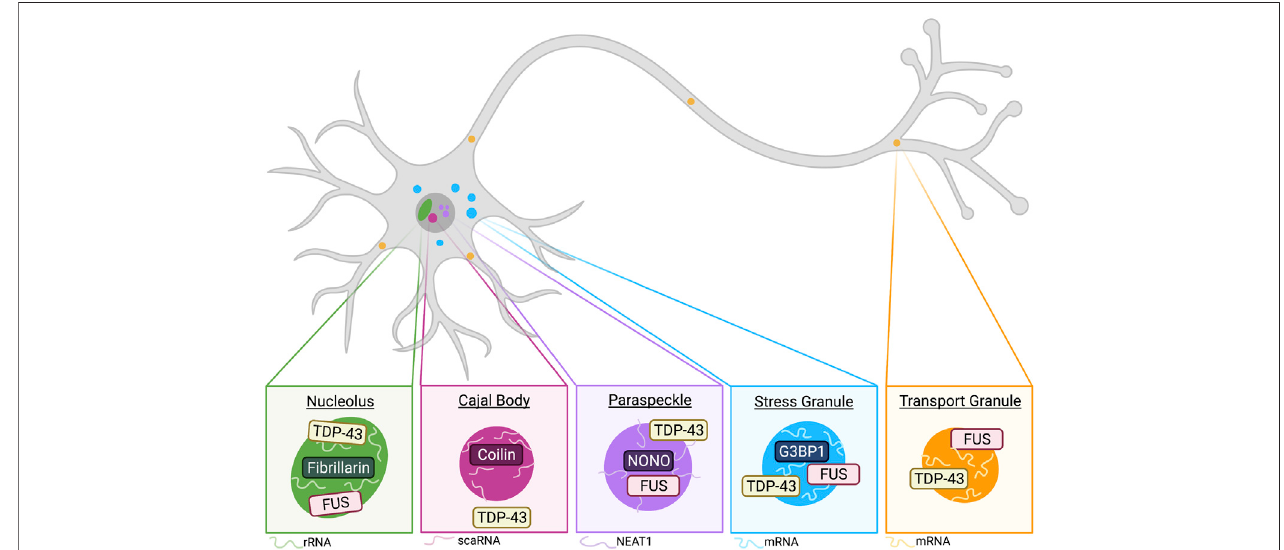
FIGURE 2 | Phase-separated membraneless organelles have distinct components and functions. Schematic of membraneless organelles implicated in TDP-43 and/orFUSbiology.Neuronscontainnucleoli,whicharecondensedregionsassociatedwithribosomalRNAsynthesis.TDP-43andFUShavebeenobservedtolocalize tothenucleolus,whichiscommonlymarkedby fi brillarinandrRNA(see Nucleoli ).Cajalbodies(CBs)arecloselyassociatedwithnucleoliandcommonlyfoundinneurons. Major CB markers include coilin and the presence of small Cajal body-speci fi c RNA (scaRNA). While not demonstrated to colocalize, TDP-43 is implicated in CB formation and regulation (see Cajal Bodies ). Another nuclear membraneless organelle relevant to TDP-43 and FUS biology includes paraspeckles (see Paraspeckles ). The long non-coding RNA (lncRNA) NEAT1 is an integral RNA component of paraspeckle organization, and these condensates are commonly marked by NONO. TDP- 43 hasbeen demonstratedto beimportantregulator ofparaspeckle formation and itisshown tolocalizetothe shell ofparaspeckles,whereas FUS isgenerallylocalized to the core (West et al., 2016). Cytoplasmic stress granules are recently implicated in neurodegenerative diseases, and G3BP1 has been demonstrated as a central protein involved in SG formation (Yang et al., 2020). Stress granules stall protein translation and mRNA is acommon RNAcomponent ofthese condensates. Both TDP- 43 and FUS demonstrate SG recruitment in neurons (see Stress Response ). A fi nal membraneless organelle covered in this review includes transport granules. These granules are observed in dendrites and axons ofneurons. TDP-43 and FUS are both implicated in their formation, and these condensates often include mRNA, which is shuttled away from the soma for local translation (see Transport Granules and Local Translation ). Created with